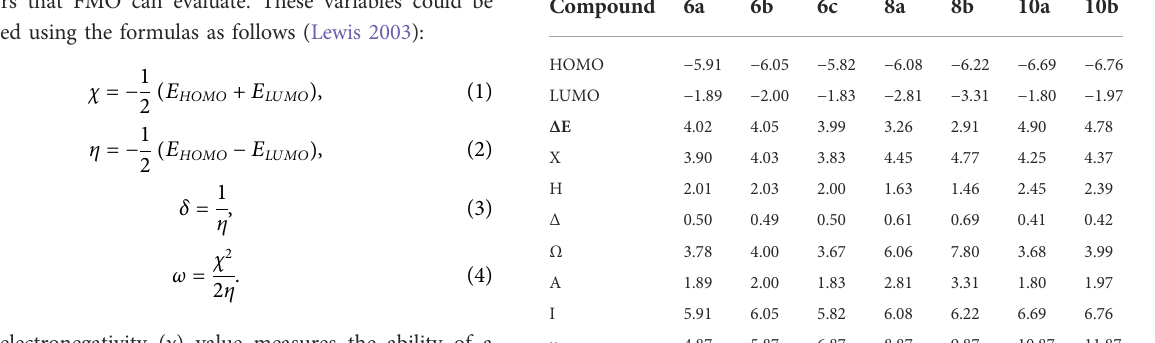
TABLE 1 Chemical reactivity descriptors and dipole moment (µ, Debye) of investigated compounds (6a – c, 8a, b, and 10a, b).